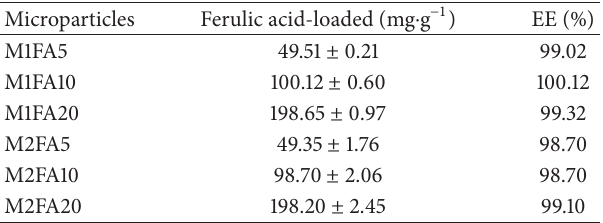
Table 6: Ferulic acid-loaded ∗ and encapsulation efficiency (EE) for PHBV/PCL